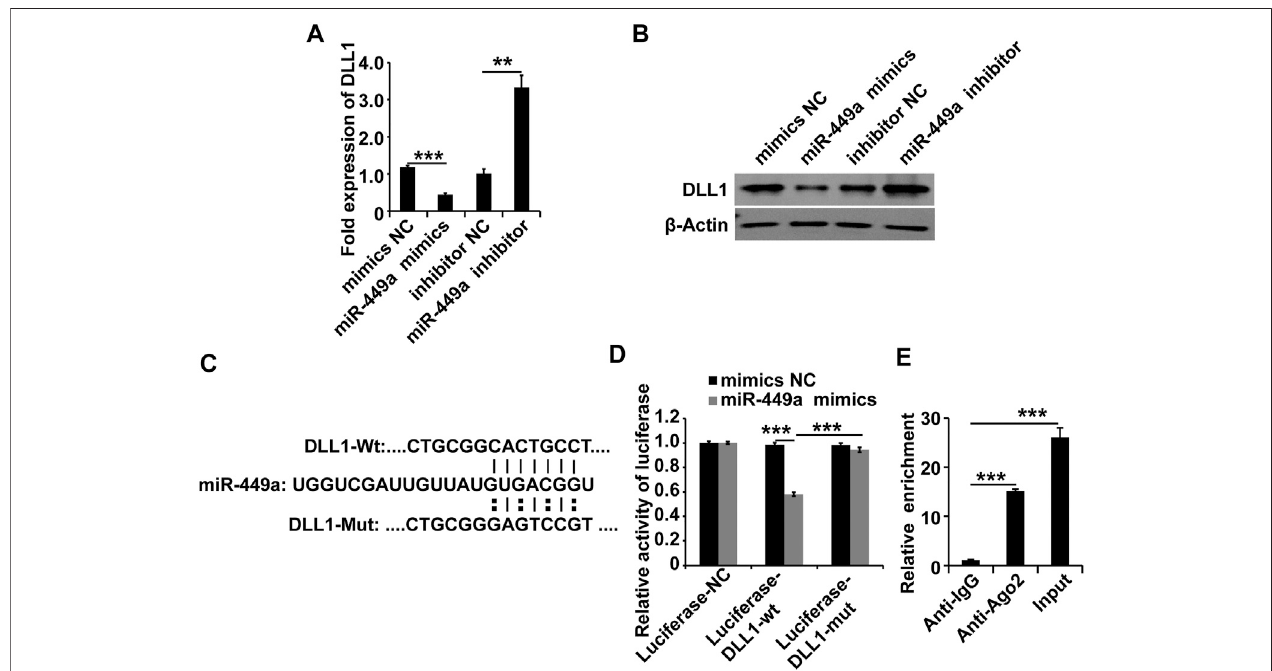
FIGURE4| miR-449atargetsDLL1. (A – B) HGSMCsweretransfectedwithamiR-449amimic,amiR-449ainhibitor,ortherespectivecontrols(NC),and48 hlater, the DLL1 mRNA and protein levels were detected by qPCR and western blotting. (C) Predicted binding site of miR-449a on the 3 ′ UTR of DLL1. (D) luciferase reporter assay analysis of the interaction between miR-449a and DLL1. (E) RIP assay analysis of the interaction between miR-449a and DLL1. U6 or β -Actin was used as an internal control. *** p < 0.001, ** p < 0.01, * p <